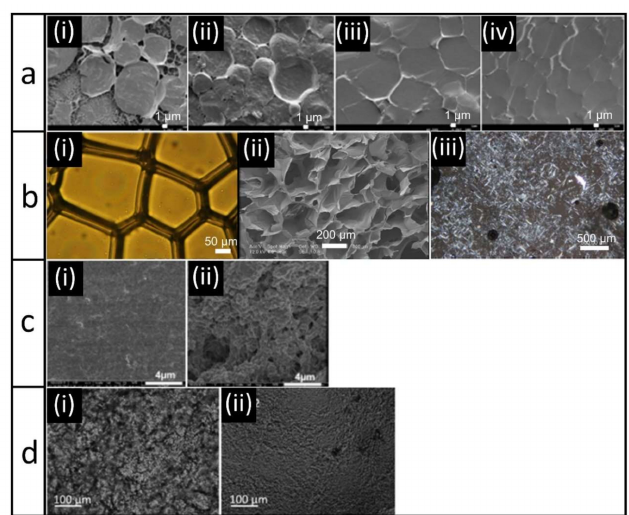
Figure 2. ( a ) Cryo-SEM images of emulsions at pH 5.5 (i) and pH 7 (ii) and corresponding oleogels (iii,iv) based on caseinate and alginate. Images were reproduced from Wijaya et al. [87] with permission from Elsevier; ( b ) optical image of aqueous foam (i), electron image of aerogel (ii), and polarized light microscopy image of oleogel (iii) obtained from a combination of gelatin and xanthan gum. Images were reproduced from Abdollahi et al. [92] with permission from Wiley; ( c ) Cryo-SEM images of whey protein isolate (WPI) oleogels obtained from hydrogel templates at low (i) and high (ii) ionic strength (0 or 100 mM NaCl) [95]. All images were reprinted from Langmuir 2015, 31, 13850–13859. Copyright 2015 American Chemical Society; ( d ) Optical microscopy images of an oleogel prepared by direct dispersion of freeze-dried (i) or CO 2 -dried (ii) WPI-aggregates. Images were reproduced from Plazotta et al. [98] with permission from